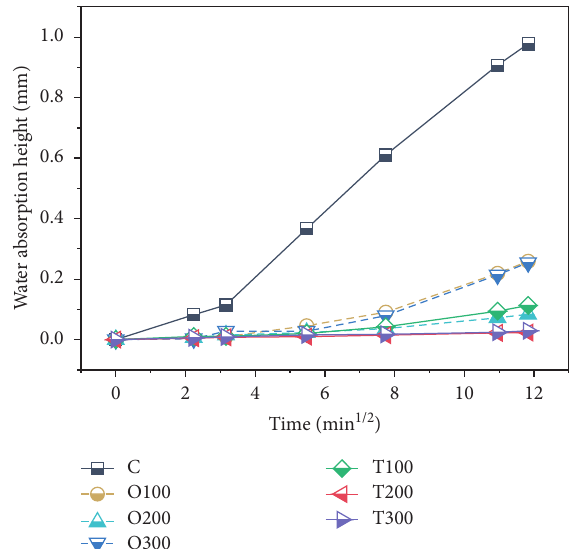
Figure 6: Water absorption height of sample under different coating methods.